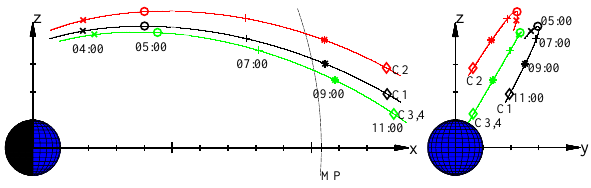
Figure 1. Orbit of Cluster 1 (black), Cluster 2 (red), and Cluster 3 (green) relative to the planet on 15 March 2007. The Cluster 4 spacecraft was very close to Cluster 3, and the green line therefore represents the orbit of both those spacecraft. The left-hand panel shows the x − z plane in GSE coordinates and the right-hand panel shows the y − z plane. The dashed black curve (marked “MP”) in the left panel shows a Shue model magnetopause. The distance between two ticks on the axes is 1 R E .